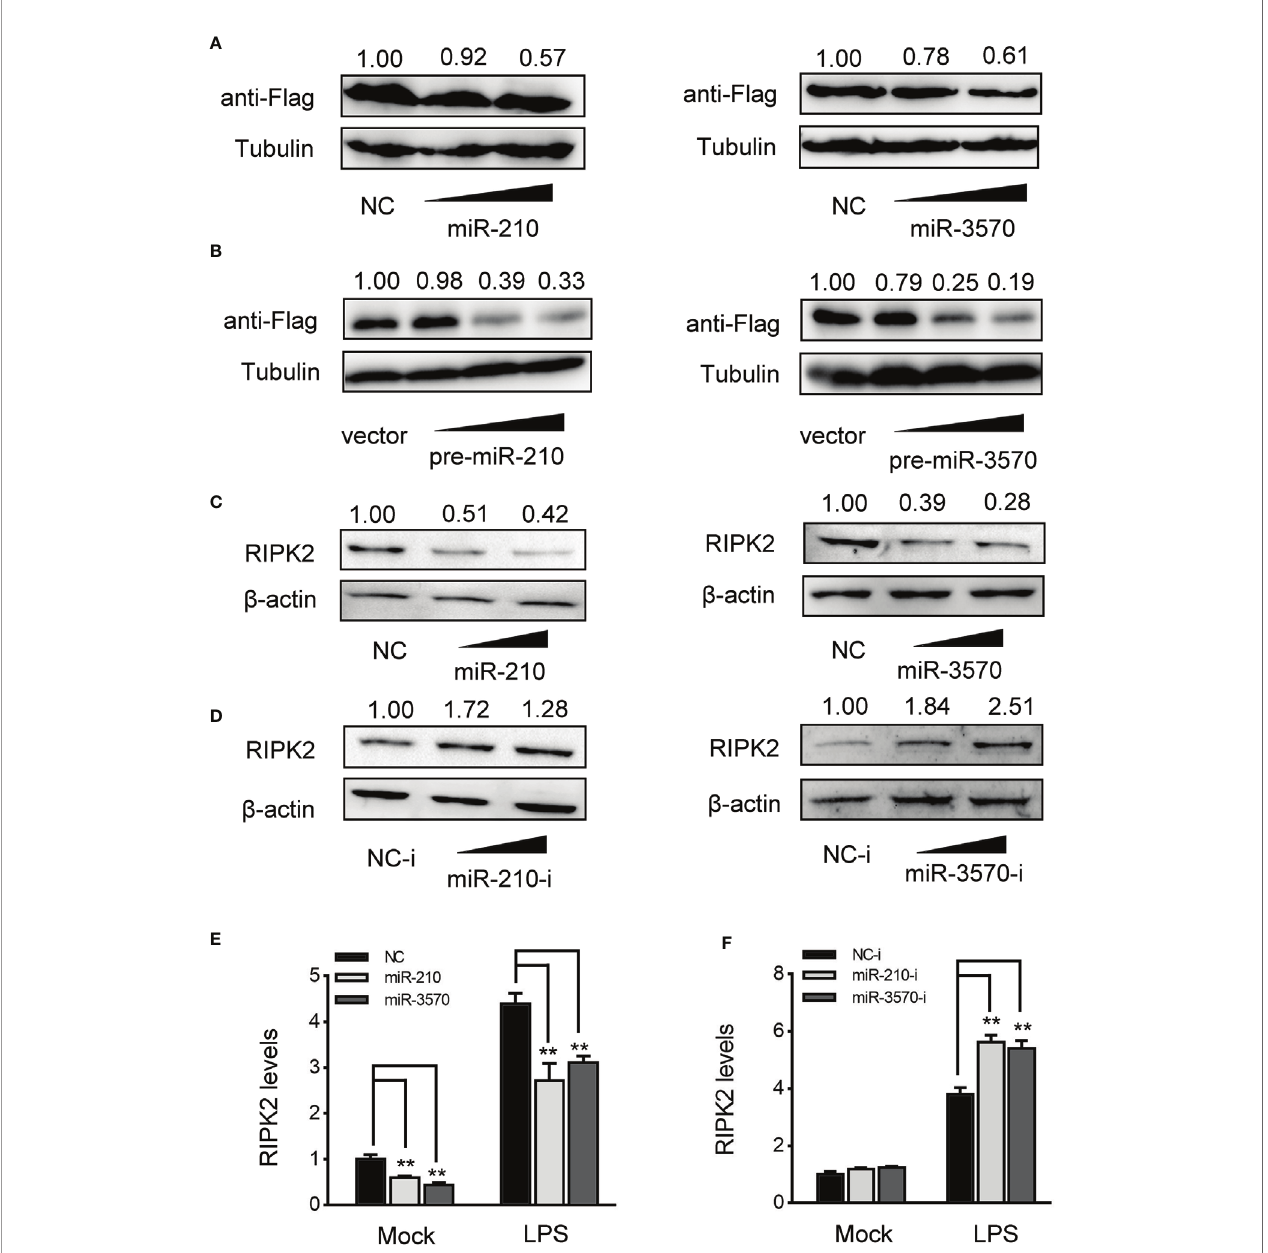
FIGURE 4 | miR-210 and miR-3570 decrease the expression of RIPK2. (A) EPC cells were cotransfected with RIPK2 expression plasmid along with miR-210 mimics (0, 50, 100 nM), and miR-3570 mimics (0, 50,100 nM) or NC (100,50, 0nM) in EPC cells. After 48 h, RIPK2 protein levels were detected by western blotting and normalized to b -actin, respectively. (B) The concentrate gradient experiments were conducted for pre-miR-210 and pre-miR-3570 transfection. For the concentrate gradient experiments, pre-miR-210 plasmid (0, 50, 100, 200 ng) (left), pre-miR-3570 plasmid (0, 50, 100, 200 ng) (right), or pcDNA3.1 vector (200, 150, 100, 0 ng) along with RIPK2 expression plasmid cotransfected into EPC cells, After 48 h, expression of RIPK2 protein were assessed by western blotting, using b -actin as a loading control. (C, D) MIC cells were transfected with NC, miR-210 and miR-3570 (C) , or NC-i, miR-210-i and miR-3570-i (D) , after 48 h, RIPK2 protein levels were determined by western blotting and normalized to b -actin. (E, F) MIC cells contransfected with NC, miR-210 and miR-3570 (E) or NC-i, miR-210-i, and miR-3570-i (F) for 48 h, the MIC cells were treated with LPS for 6 h and RIPK2 mRNA expression was determined by qPCR and normalized to b -actin. The results are standardized to 1 in control cells. All data are presented as the means ± SE from three independent triplicate experiments. **p < 0.01 versus the